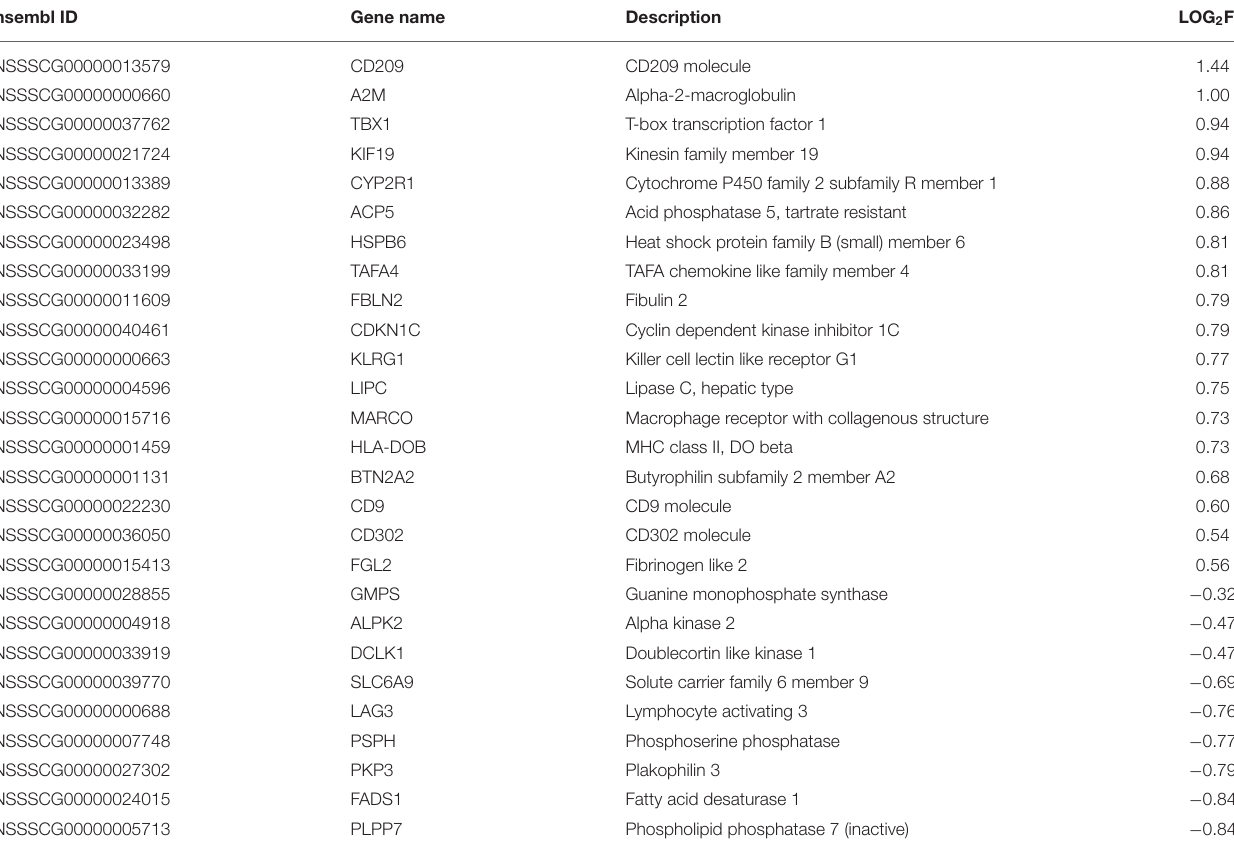
TABLE 3 | Unique genes differentially expressed by